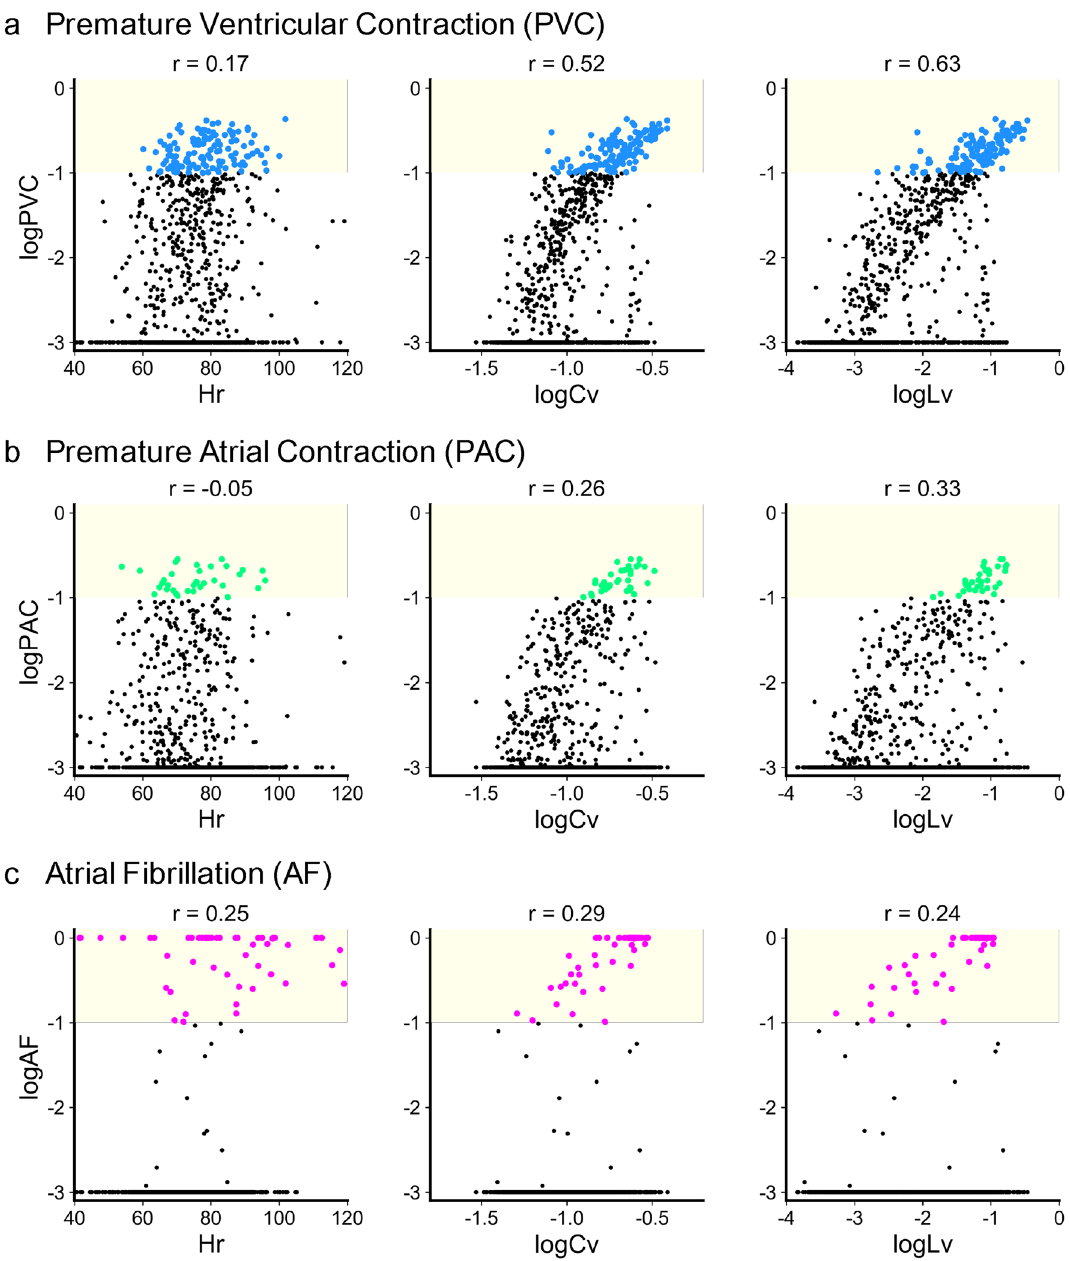
Figure 1. Cardiac disorders plotted against Hr , log 10 Cv , and log 10 Lv . Each dot represents the average of 10-minute statistics for a single subject over 18 hours. Vertical axes are the logarithm of ( a ) premature ventricular contraction (PVC); ( b ) premature atrial contraction (PAC); and ( c ) atrial fibrillation (AF). Values of the Pearson correlation r are indicated above. Yellow zones represent regions of > 0.1